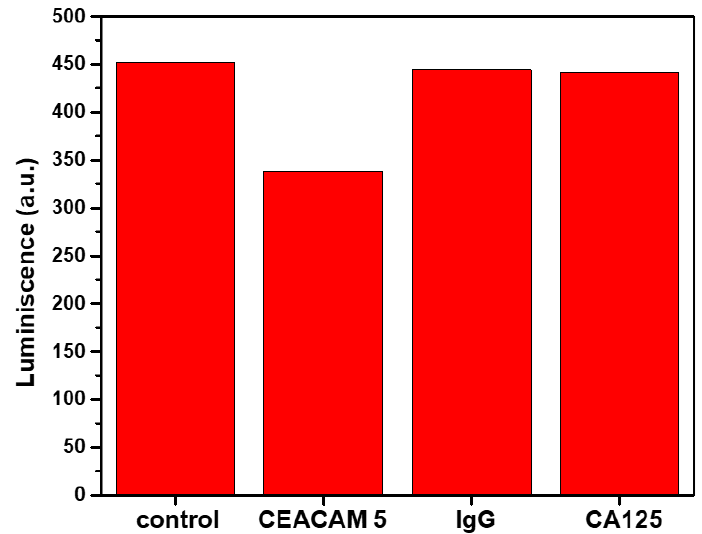
Figure 7. Luminescence intensities of the QD@Ab grafted onto the nanoplatform paper@AuNR648, as a control, and in the presence of CEACAM 5, human IgG and CA-125 biomarkers.